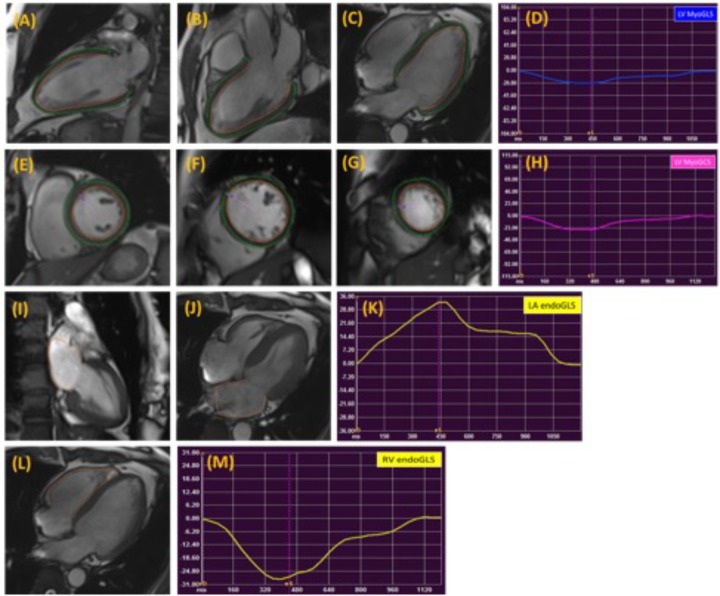
Representative images in the standard long axis (A–C) and short axis (E–G) orientations and strain curves. Contours are illustrated in left ventricular endocardial and epicardial borders in the 2-, 3-, 4-chamber (A–C) and corresponding LV MyoGLS (LV Ell) (D); endocardial and epicardial borders in base, mid, apical short axis views (E–G) and corresponding LV MyoGCS (LV Ecc) (H); left atrial endocardial borders in 2-, and 4-chamber (I,J) and corresponding LA endoGLS (LA Ell) (K); right ventricular endocardial border in 4-chamber (L) and corresponding RV endoGLS (RV Ell) (M).